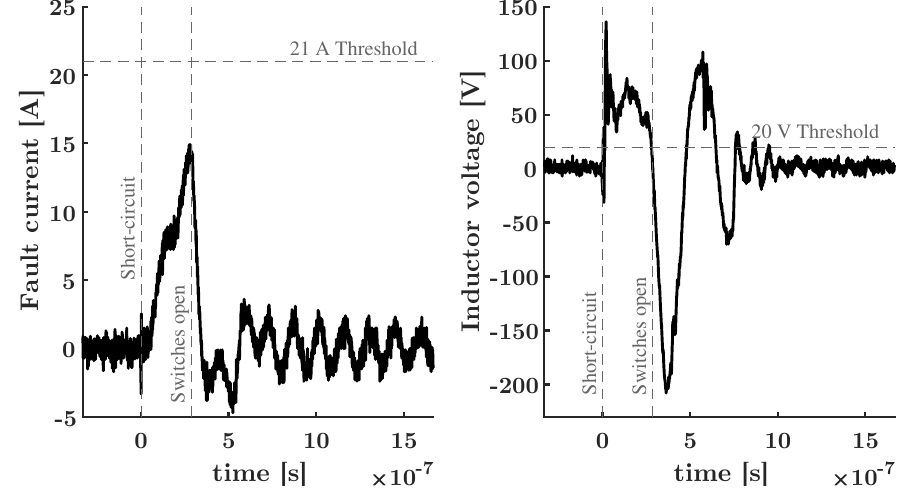
Figure 9. Experimental results when the SSCB is short-circuited with a low fault resistance resulting in the di/dt detection being triggered when the 20 V (20 MA/s) threshold is exceeded for a longer